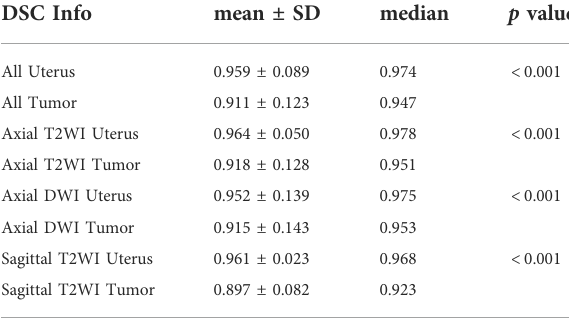
TABLE 4 DSCs of the segmented uterus and